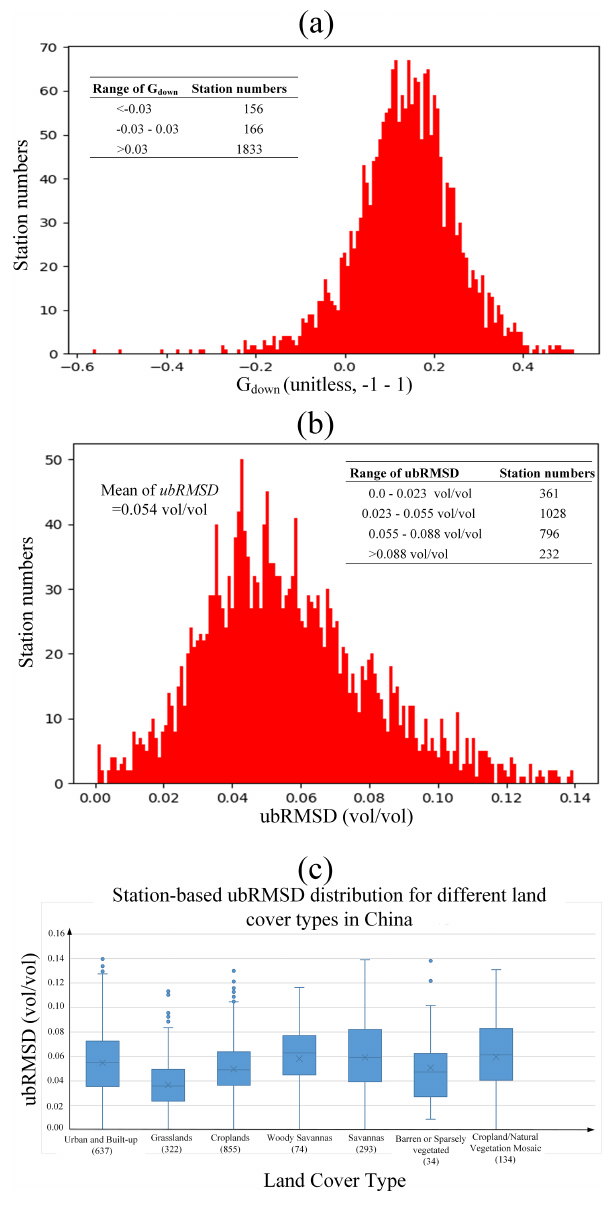
Figure 4. General validation results of the currently developed SSM product. (a) G down distribution for different stations over China. (b) ubRMSD distribution for different stations over China. (c) ubRMSD statistics reported for different land covers. The num- bers in the parentheses of the x axis labels represent the amount of meteorological stations corresponding to that specific land cover